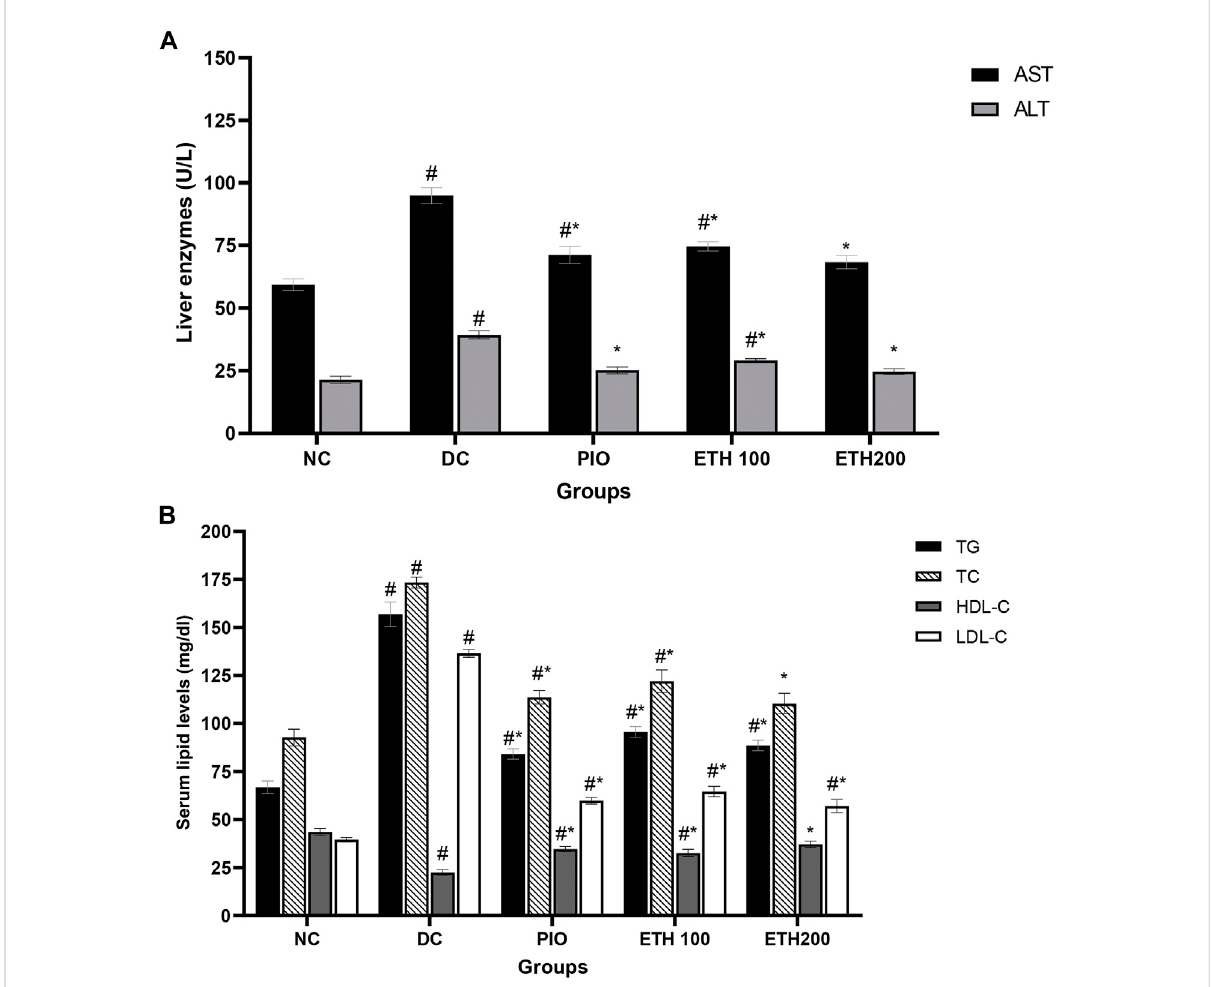
FIGURE 2 MA ethanolic extracts ameliorated the liver damage and dyslipidemia (A) liver enzymes: ALT, alanine aminotransferase; AST, aspartate aminotransferase,# p < 0.05versusnormalcontrol,* p < 0.05versusdiabeticcontrol. (B) Serumlipids:TG,triglycerides;TC,totalcholesterol;LDL-C, low density lipoprotein cholesterol; HDL-C, high density lipoprotein cholesterol. # p < 0.05 versus normal control, * p < 0.05 versus diabetic control. Data are expressed as Mean ± SEM, n = 7. Adjusting the size of the images and resolution, adding the panels ’ letters, and combining the images was carried out using